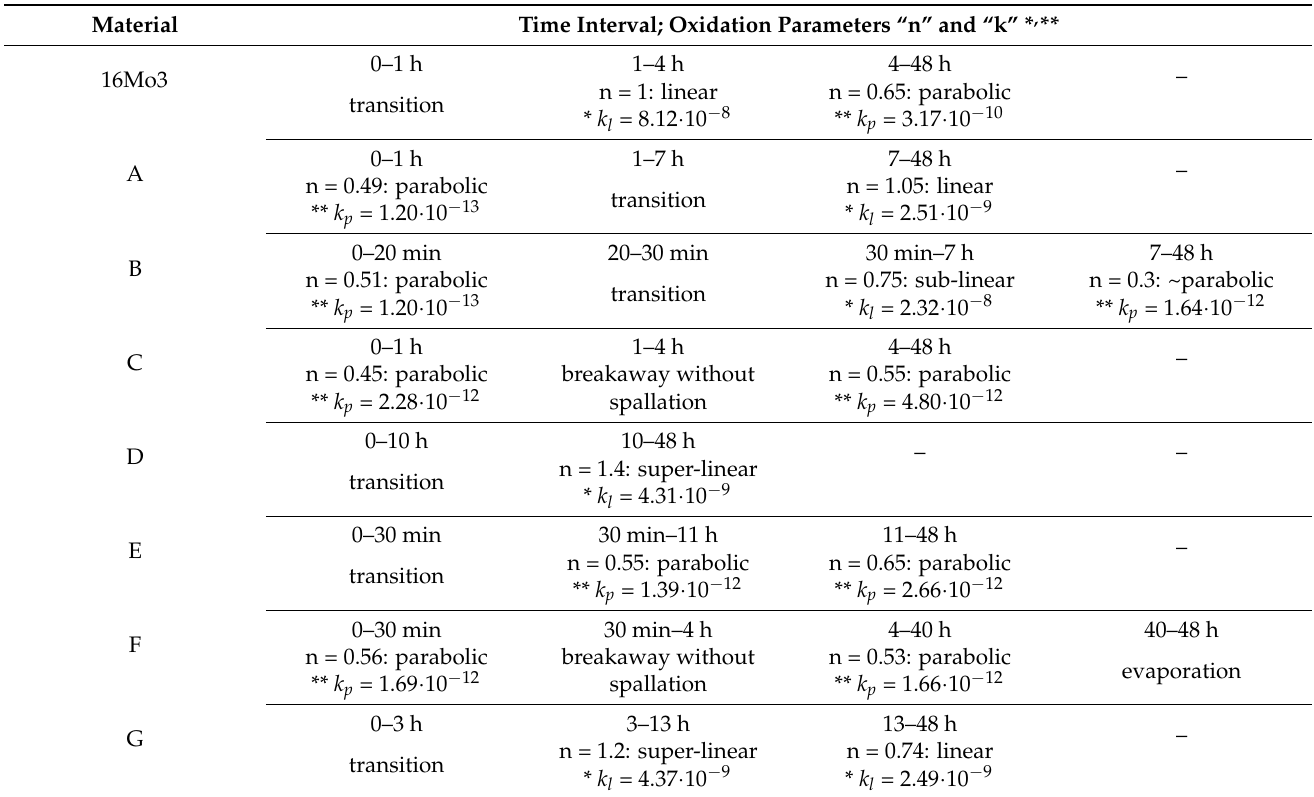
Table 3. Oxidation parameters “n” and “k” of the uncoated and coated samples as a function of different time intervals.